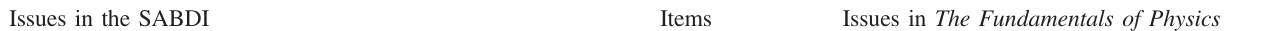
TABLE I. List of acoustic issues treated by SABDI compared to appropriate sections in The Fundamentals of Physics [28]. Issues in the SABDI Items Sound as a longitudinal wave 1, 4, 5, 7, 8,